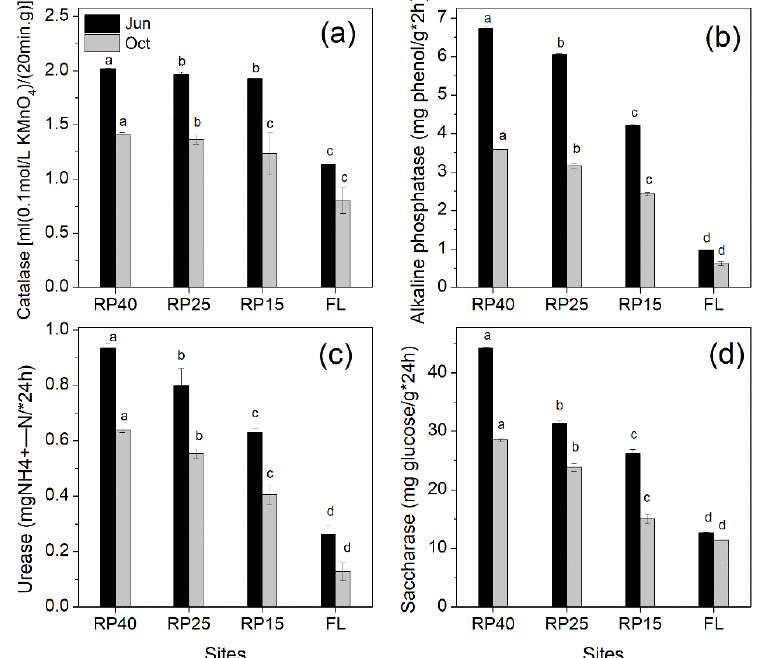
Figure 4. Soil Catalase enzyme activities ( a ), Alkaline phosphatase enzyme activities ( b ), Ureas enzyme activities ( c ) and Saccharase enzyme activities ( d ) after afforestation. Different letters denote significant ( p < 0.05) differences among sites in same month; error bar represents standard error. Note: 40, 25, and 15 years of Robinia pseudoacacia L. indicated as RP40, RP25, and RP15.